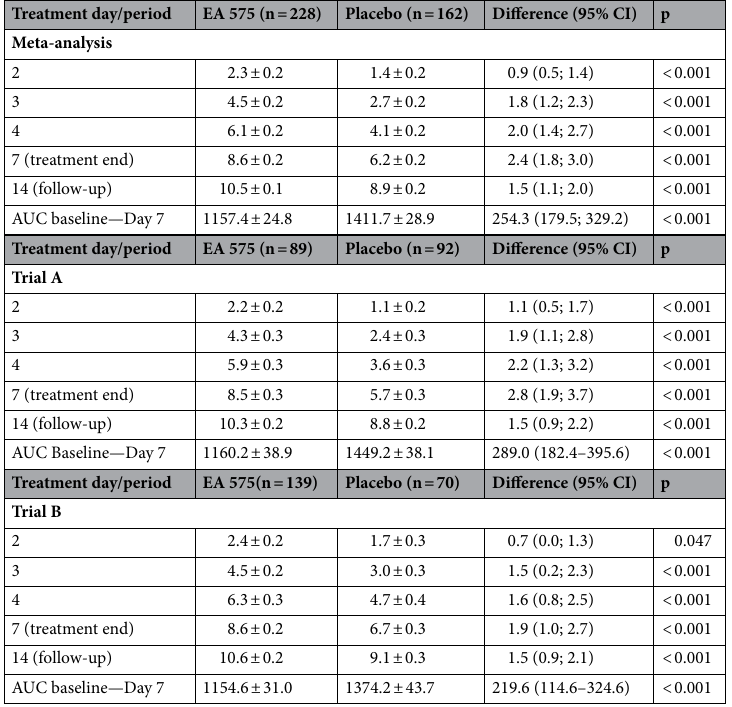
Table 2. Bronchitis Severity Score—meta-analysis and individual trial results (full analysis set; marginal means ± SEM for EA 575 and placebo, difference between marginal means and 95% confidence interval, p-value derived from treatment-by-visit interaction). CI Confidence interval, SEM standard error of the mean. BSS, observed values: score points; AUC: score points ×